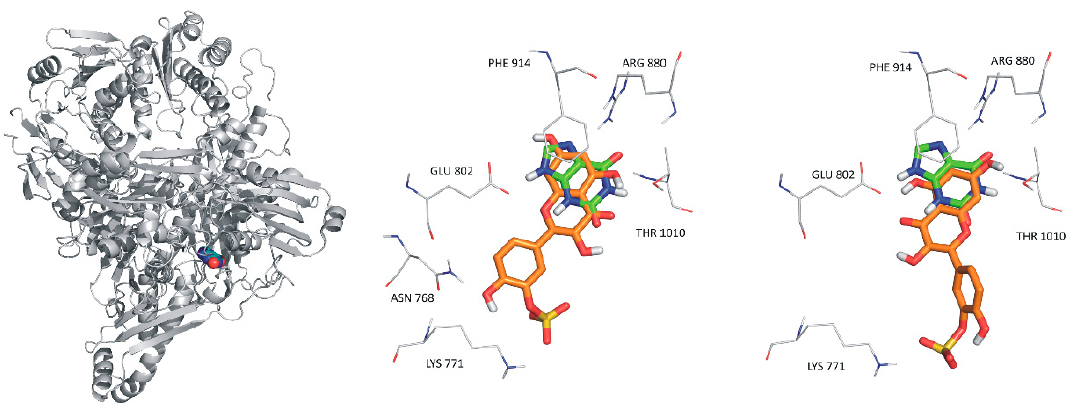
Figure 11. The reference ligand xanthine (spheres, left) occupying its binding site on XO (gray cartoon). In the rest of the panels (middle and right), xanthine is marked with green color. Rank 1 (orange, middle) and Rank 2 (orange, right) binding sites of quercetin-3 ′ sulfate in the XO enzyme.